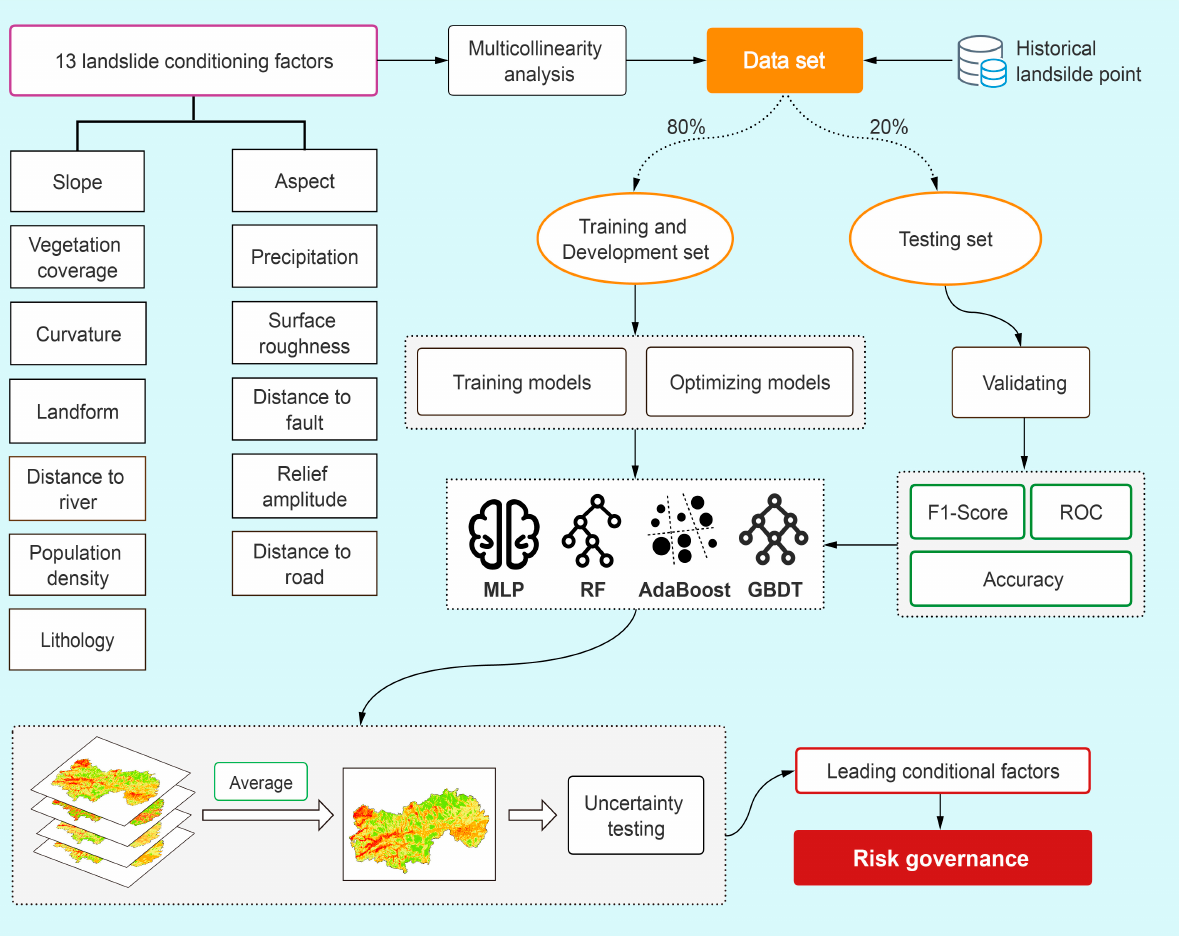
Figure 3. The research work flow. AdaBoost: adaptive boosting; GBDT: gradient-boosting decision tree; MLP: multilayer perceptron; RF: random forest.